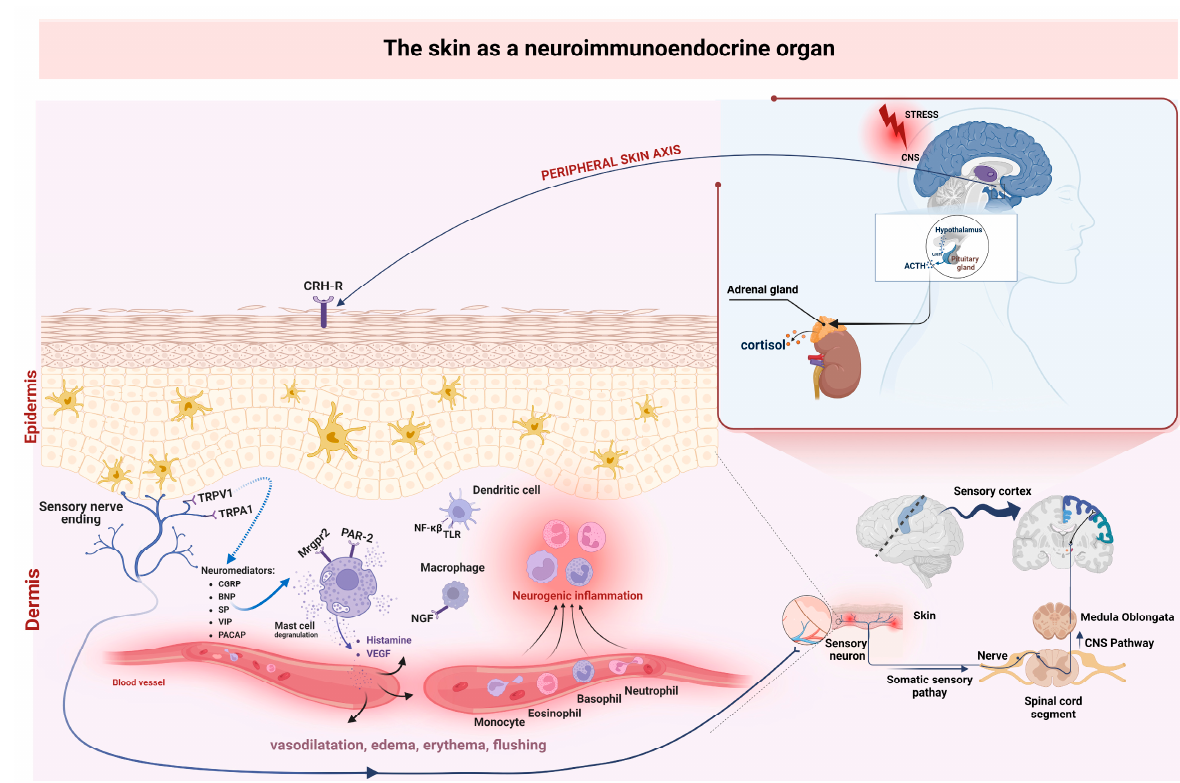
Figure 3. The central and peripheral axes of the HPA are in charge of proper skin barrier function and inflammatory reactions. The release of neuromediators (CRF) from the hypothalamus and other areas of the CNS that can stimulate the release of norepinephrine and cortisol from adrenal HPA, and the release of leukocytes in the circulatory system via CRF and MC receptors, which modulate immune responses during inflammation and immunity, are activated by various stressors. Inflammatory responses in the skin are modulated by cytokines and neuropeptides of immune cells. Protease-activated receptor 2 (PAR2) on the plasma membrane of sensory nerve endings is activated by tryptase from degranulated MCs, which, in turn, stimulates the release of calcitonin gene-related peptide and tachykinins from sensory nerve endings. Vasoactive sensory nerve peptides are released under the influence of mediators from mast cells and other inflammatory cells. The mobilization of intracellular Ca 2+ by PAR -2 at the level of the spinal cord induces the secretion of CGRP and SP from the central nerve endings. Neuromediators that are released when stimulated by sensory nerves modulate cutaneous inflammation, pain and itching.